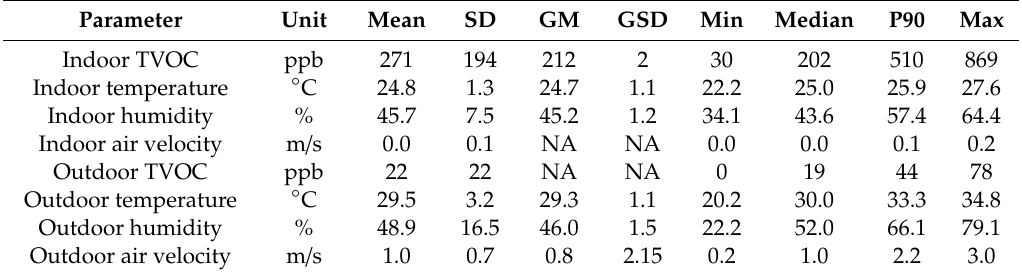
Table 1. Descriptive statistics of indoor environmental parameters measured in 32 retail